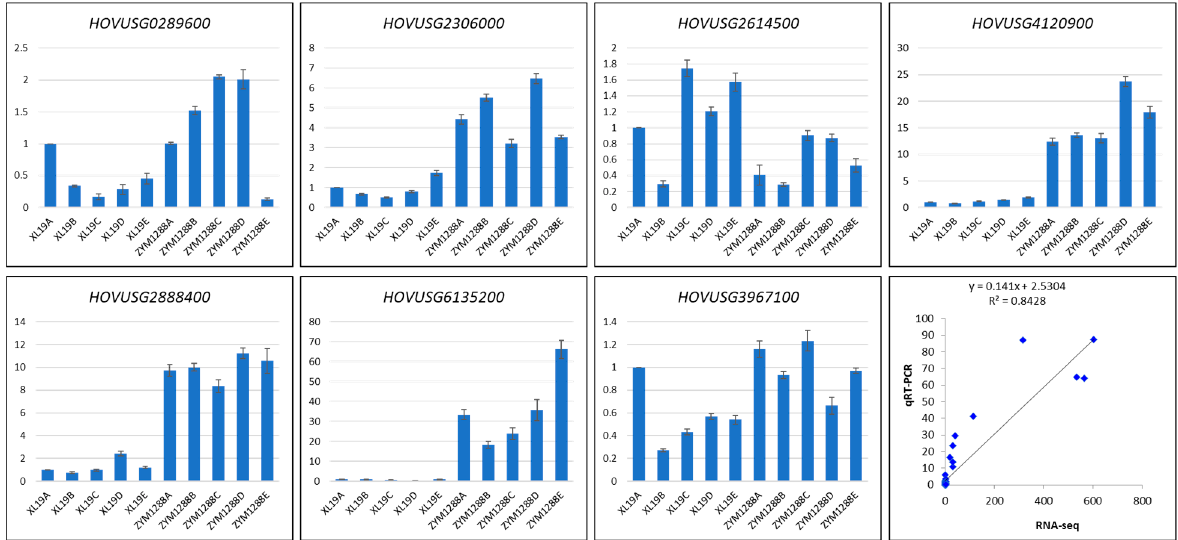
Figure 8. Quantitative real-time PCR analysis and correlation between qRT-PCR expression data and RNA-Seq data of selected DEGs in XL19 and ZYM1288. A, B, C, D, and E represent CK, and 5, 12, 24, and 36 h after the infection of Bgh.